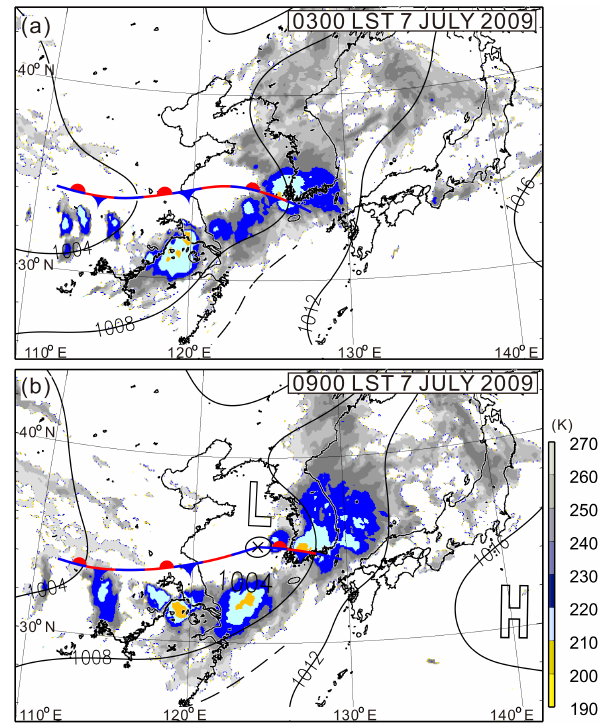
Figure 3. Surface weather maps with superimposed MTSAT-IR images (colour shading) at (a) 03:00LST, and (b) 09:00LST 7 July